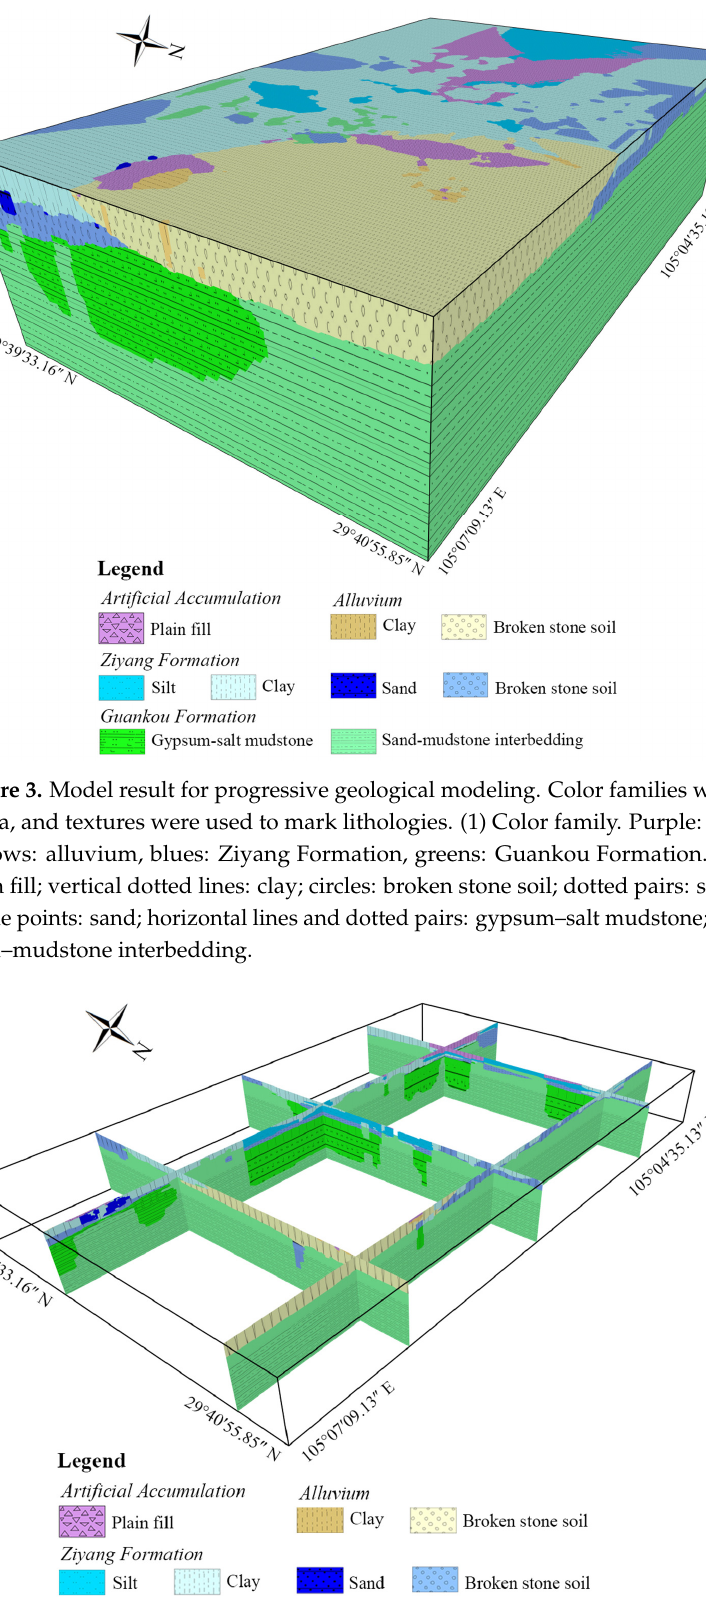
Figure 5. The lithologic 3D map of different stratum in the geological model. ( a ) Qh ml ; ( b ) Qh apl ; ( c ) Qp 3 -Qhz; ( d ) K 2 g.